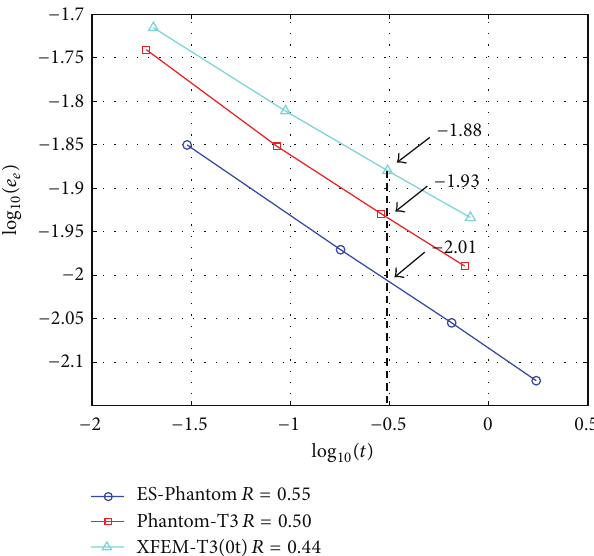
Figure 12: The convergence in the stress intensity factor 𝐾 𝐼 versus ℎ (mesh size) for the sheet with edge crack under tension.